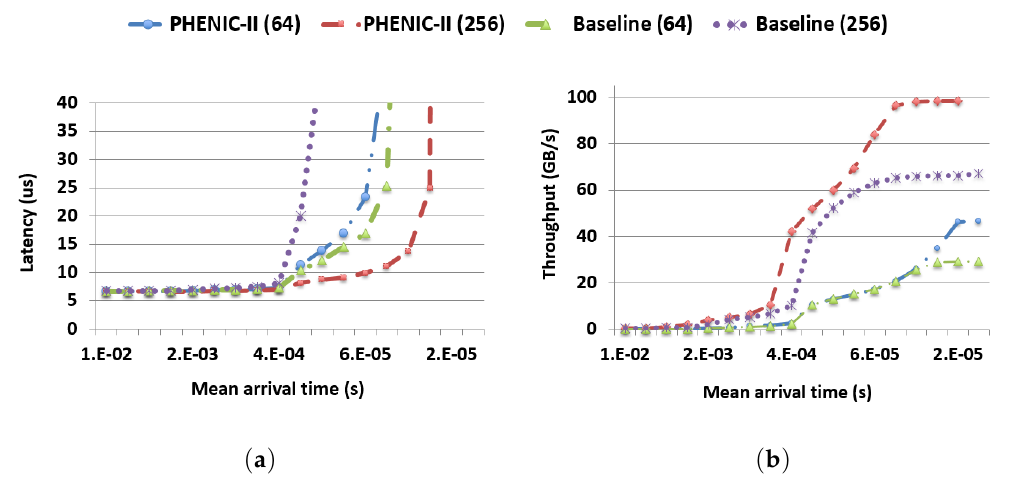
Figure 6. PHENIC-II performance evaluation under random traffic: ( a ) latency; ( b ) throughput.